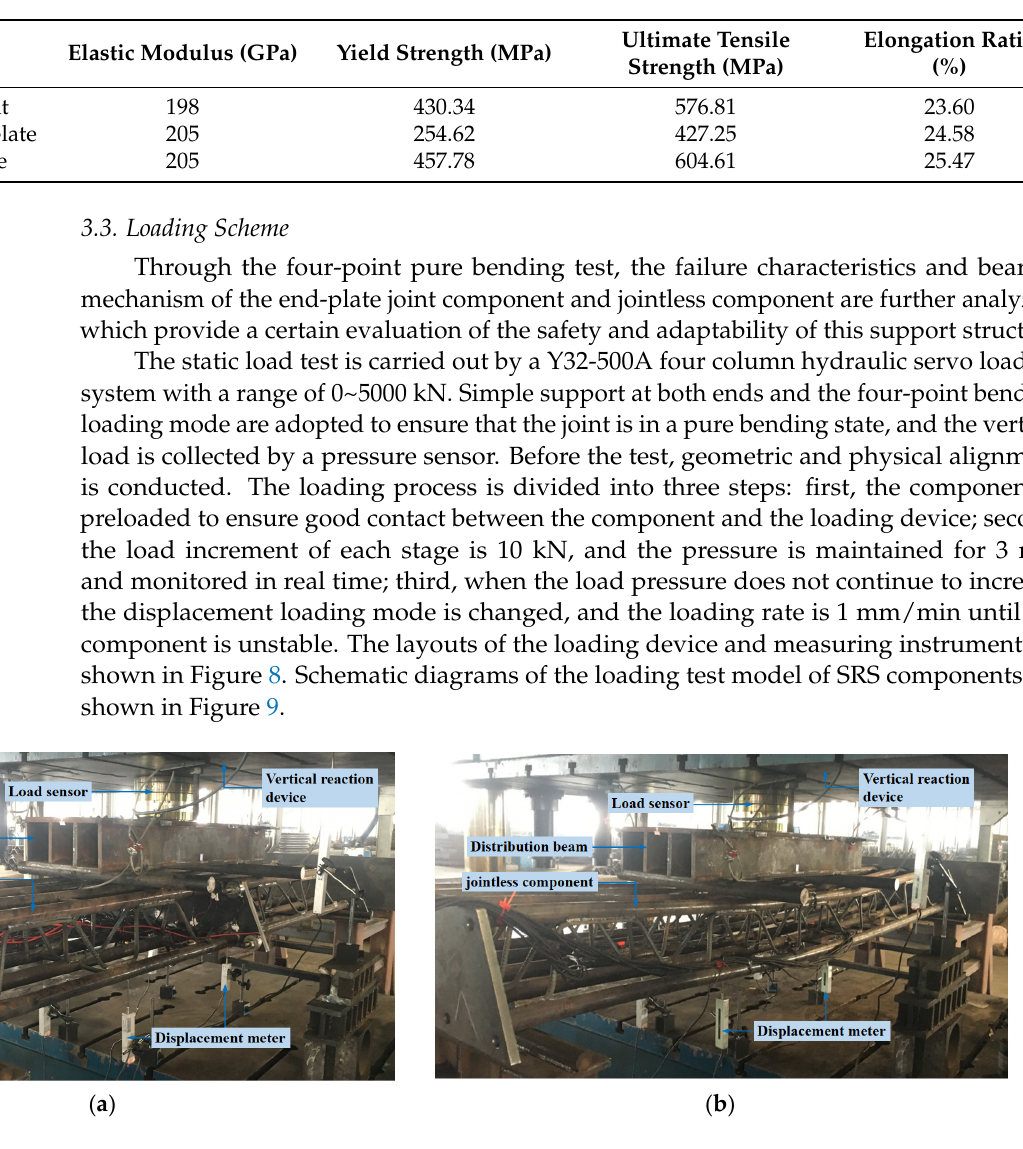
Table 2. Mechanical properties of the steel materials.